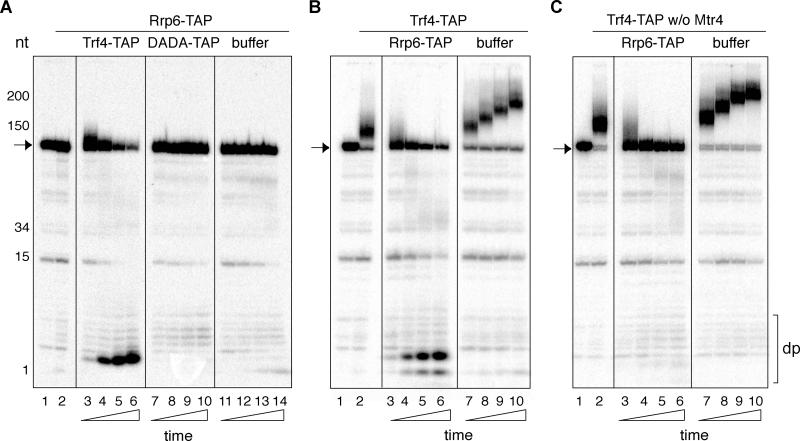
The Polyadenylation Activity of the Trf4 Complex Stimulates the Degradation of Unmodified tRNAi
Met by the Nuclear Exosome(A) The PAP activity of Trf4 complex is required to stimulate the exosome activity. In a coupled exosome/polyadenylation assay, 5′-end-labeled unmodified tRNAi
Met was incubated with 50 ng of affinity-purified Rrp6-TAP eluate for 30 min as described in Materials and Methods (lane 2), followed by addition of 50 ng of wild-type (Trf4-TAP), mutant complex (DADA-TAP), or buffer A (buffer). Reactions were stopped after 10 (lanes 3, 7, and 11), 30 (lanes 4, 8, and 12), 60 (lanes 5, 9, and 13), or 90 min (lanes 6, 10, and 14) and separated on a 15% gel. Arrows indicate the position of the input tRNA. Protein was omitted in lane 1 of each gel. The migration positions of the degradation products (dp) are indicated by a bracket.(B) Coupled polyadenylation/exosome assay. The 5′-end-labeled unmodified tRNAi
Met was pre-adenylated with 50 ng of affinity-purified Trf4-TAP complex for 30 min (lane 2). Then 50 ng of exosome complex (Rrp6-TAP) or buffer A (buffer) was added, and the reactions were continued as in (A).(C) Depletion of Mtr4p results in incomplete degradation. Coupled-assay, 5′-end-labeled unmodified tRNAi
Met was pre-incubated for 30 min with Trf4p-TAP lacking Mtr4p (Trf4-TAP w/o Mtr4), followed by the addition of 50 ng of Rrp6-TAP complex or buffer A, and the incubation was continued as in (A).